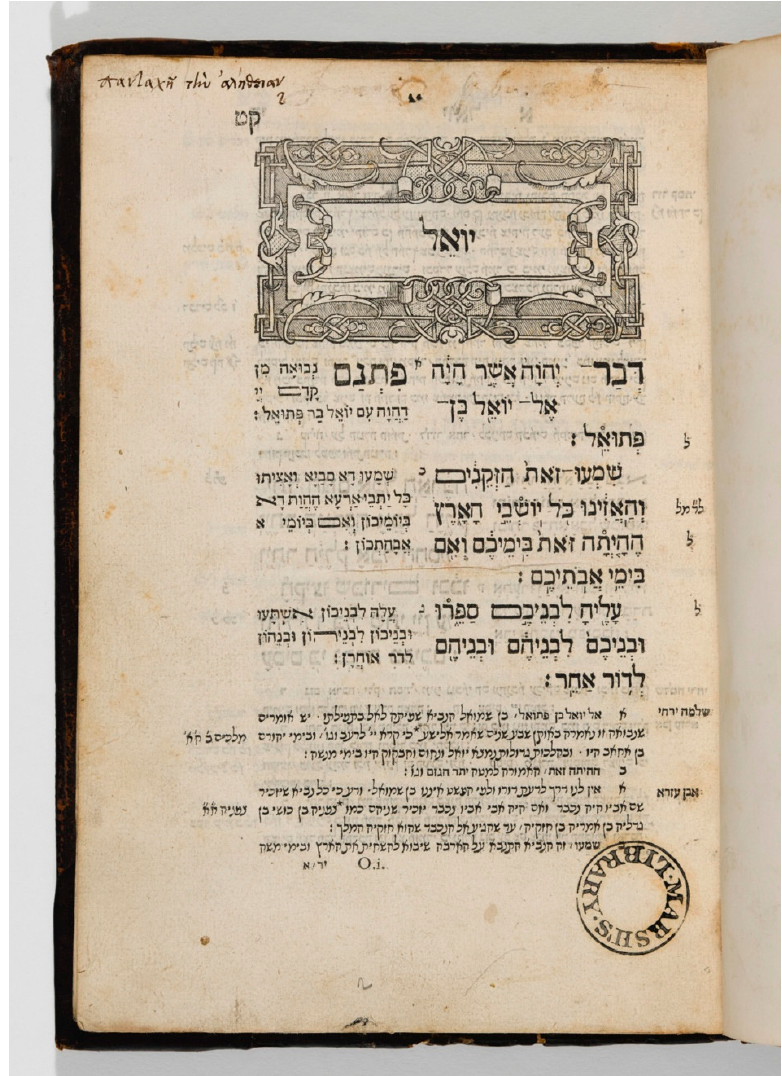
Figure 9. Hebrew Minor Prophets with Targum and Rabbinic Commentary, Book of Joel; Marsh’s